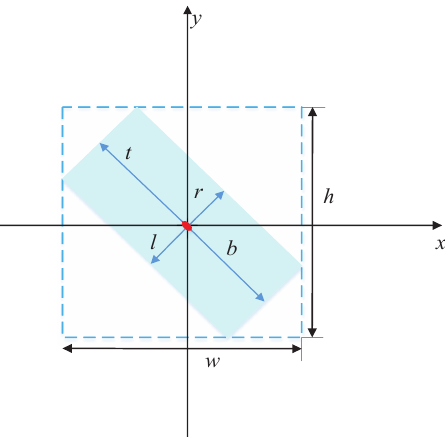
Figure 6. Parameters used to describe the bounding